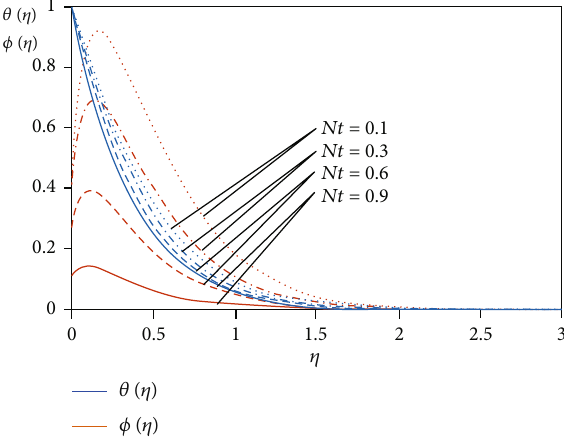
Figure 8: Concentration and temperature pro fi les a ff ected by thermophoresis